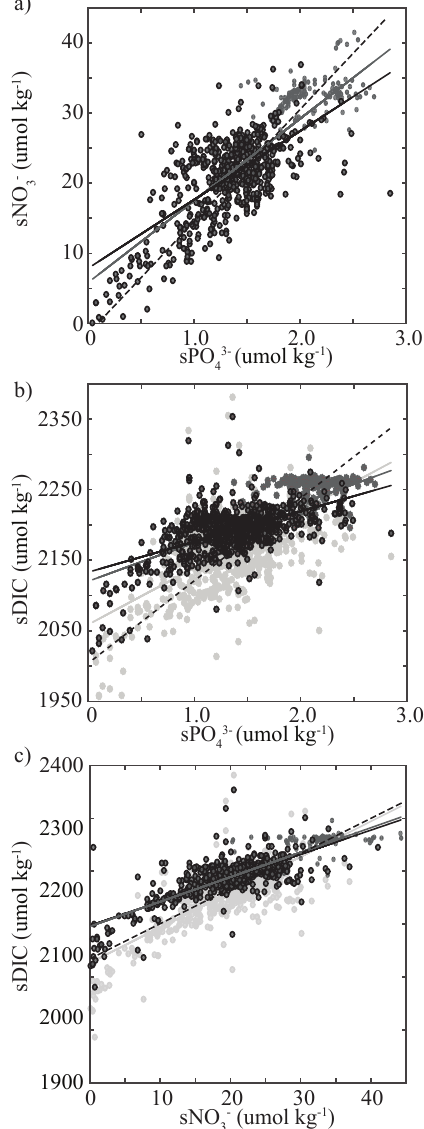
Figure 7. Plot of salinity-normalized nutrients and dissolved inor- ganic carbon (sDIC, µmolkg − 1 ) , (a) sPO 3 − (µmolkg − 1 ) vs. sNO − 4 3 (µmolkg − 1 ) , (b) sPO 3 − vs. sDIC, and (c) sNO − vs. sDIC. Ob- 4 3 servations within the mixed layer (depth <50m) are illustrated by black circles. The light-grey dots in (b) and (c) show sDIC corrected for gas exchange as a function of sPO 3 − and sNO − , respectively. A 4 3 linear fit is represented by the solid black line for the mixed layer, by the solid grey line for all data, and by the light-grey line for the gas-exchange-corrected sDIC in (b) and (c) . The dashed black lines are the nutrient drawdown lines using the corresponding Redfield ratio and data from the Upper Circumpolar Deep Water (UCDW) as end